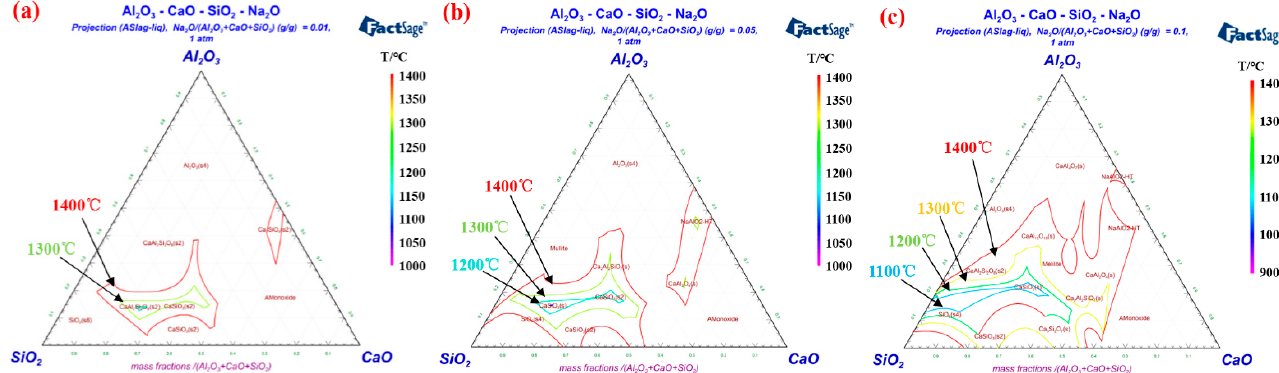
Figure 11. The phase diagram, including ( a ) phase diagram of Al 2 O 3 -CaO-SiO 2 -Na 2 O (0.01%); ( b ) phase diagram of Al 2 O 3 -CaO-SiO 2 -Na 2 O (0.05%); ( c ) phase diagram of Al 2 O 3 -CaO-SiO 2 -Na 2 O (0.10%) [43] .